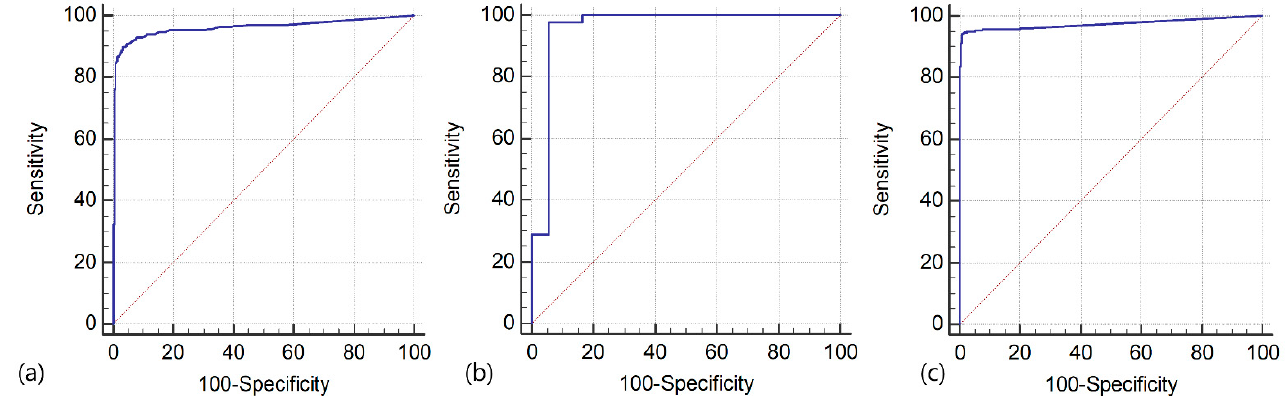
Figure 2. Receiver operating characteristic curves for FNA-Tg measurements in patients assessed preoperatively ( a ), after lobectomy ( b ), and after total thyroidectomy ( c ). The areas under the curves were 0.962, 0.958, and 0.974, respectively and p < 0.001; FNA, fine-needle aspiration; Tg, thyroglobulin.